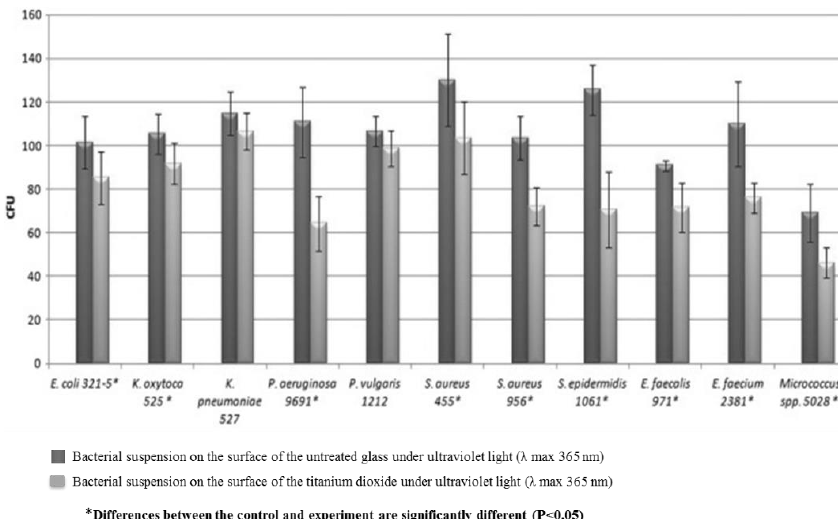
Figure 6. Colony forming units (CFUs) of various bacteria strains after incubation under UV for 15 min on the surface of sterile glass (control) and TiO 2 . Reprinted with the permission from [113]; Copyright 2015 Elsevier B.V.